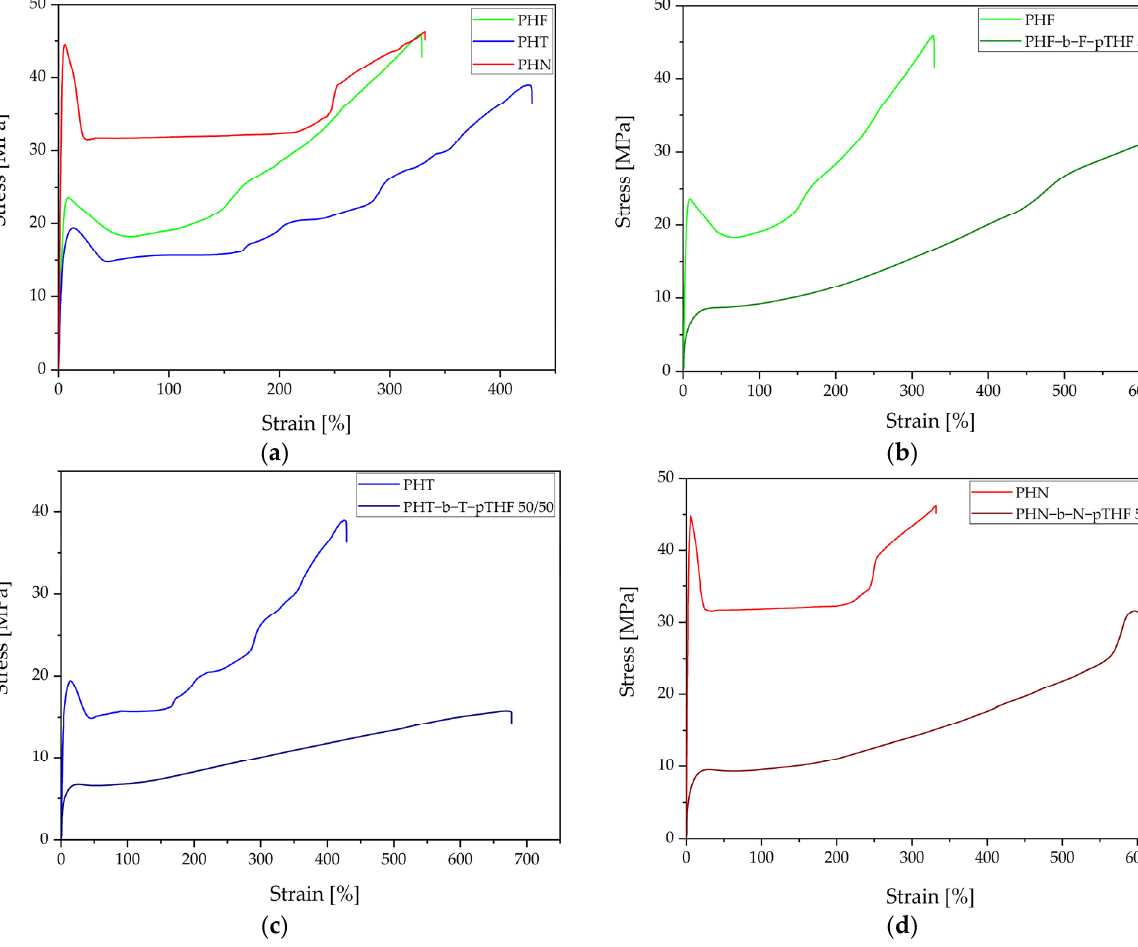
Figure 13. Representative stress-strain curves of static tensile test for synthesized materials ( a ) polyesters, ( b ) PHF and PHF-b-F-pTHF 50/50, ( c ) PHT and PHT-b-T-pTHF 50/50, ( d ) PHN and PHN-b-N-pTHF 50/50.